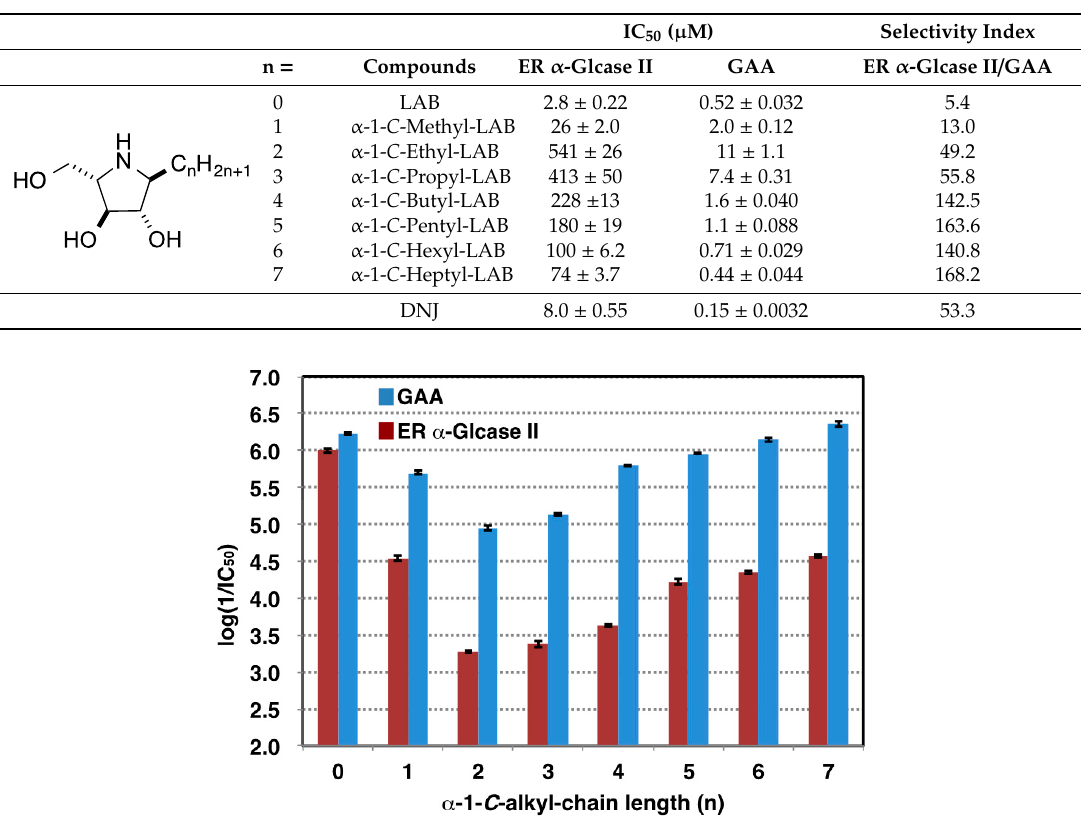
Figure 3. The effect of alkyl chain length on inhibitory activities against GAA (blue bar) and ER α -glucosidase II (red bar). Inhibition strength of GAA in each alkyl chain was indicated by log (1/IC 50 ). n: α -1- C -alkyl-chain length.